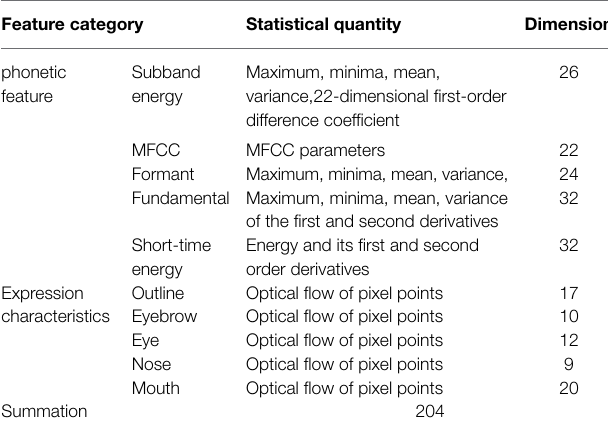
Figure 9 is the Valence-Arousal coordinate system diagram.